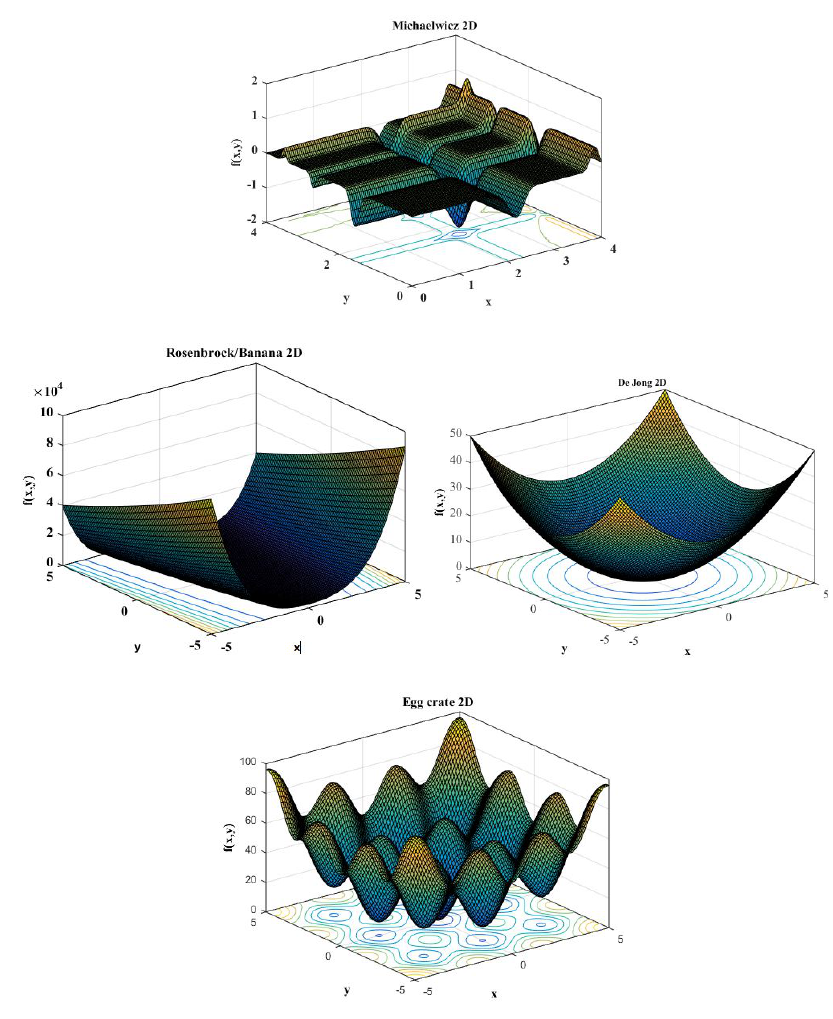
Figure 13. Plots of selected